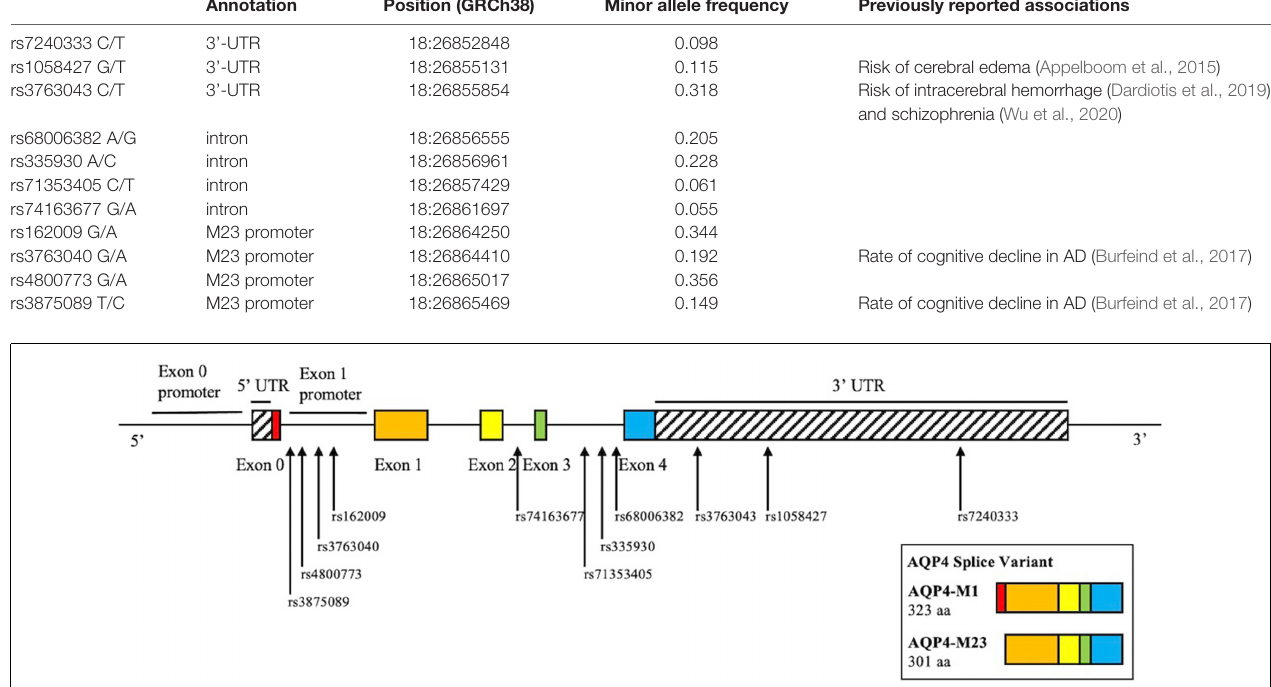
FIGURE 1 | Schematic illustration of the investigated SNPs in the AQP4 gene. There are two isoforms of AQP4, M1, and M23. M1 consists of exon 0–4, M23 consists of exon 1–4. rs162009 locates in between exon 0 and 1, which presumably acts as the promoter of the M23 isoform.